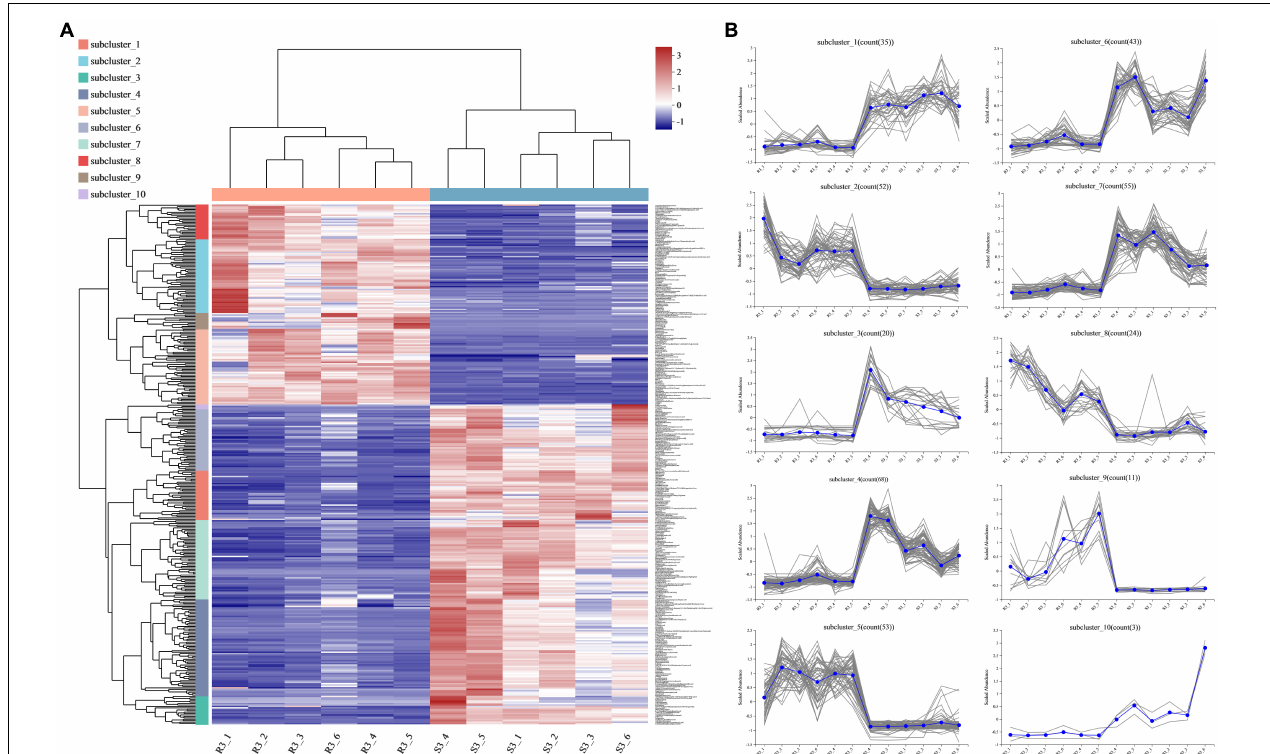
FIGURE 5 | Metabolites expression patterns between the compatible and incompatible interaction at 96 hpi. (A) Metabolites with altered abundances [irrespective of the p -value and variable importance in projection (VIP) value] at 96 hpi were divided into ten subclusters according to the expression patterns; each column represents a sample, each row represents a metabolite, and the color indicates the relative abundance of metabolites. (B) Number of metabolites for each